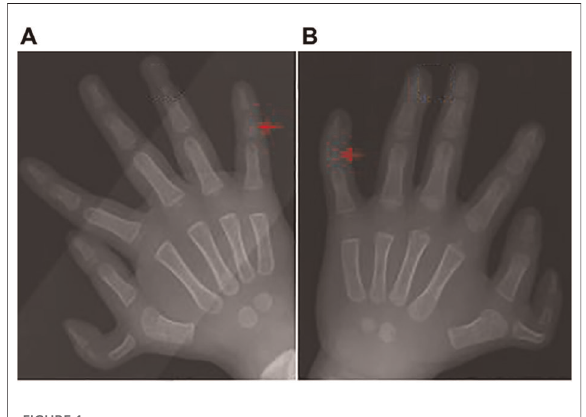
FIGURE 1 The most common associated anomaly: the red arrow highlights the middle phalanx anomalies of little fi